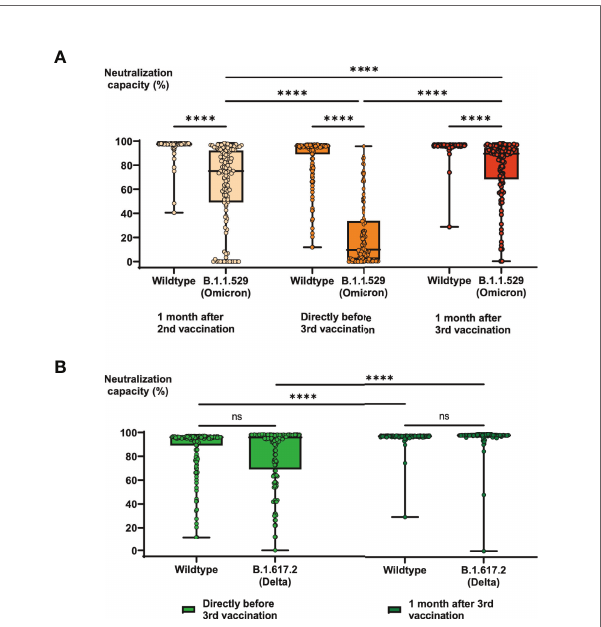
FIGURE 2 | Speci fi c neutralization capacities against current SARS-CoV-2 variants of concern in COVID-19-convalescent individuals before and after booster vaccination. Serum samples from up to 147 subjects with con fi rmed COVID-19 history were collected one month after second vaccination with BNT162b2, 6 months after second vaccination (directly before third vaccination), and one month after third vaccination. Samples were then analyzed for speci fi c neutralization capacities against wiltype SARS-CoV-2 as well as the variants of concern and B.1.1.529 (Omicron) and B.1.617.2 (Delta). Box blots show (A) neutralization capacities against B.1.1.529 compared with wild type and (B) neutralization capacities against B.1.617.2 compared with wild type at different time points as indicated. Box central horizontal lines indicate medians, box borders represent IQR, whiskers indicate minima and maxima. Signi fi cance level was ****p < 0.00005. IQR, interquartile ranges; ns, not signi fi cant.